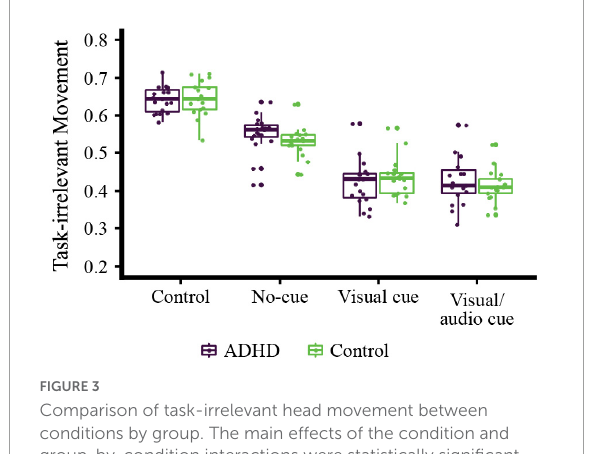
FIGURE3 Comparison of task-irrelevant head movement between conditions by group. The main effects of the condition and group-by-condition interactions were statistically significant, while the main effects of group were not. According to the post-hoc analyses performed with FDR correction, the healthy control (HC) group showed statistically significant differences between all conditions; however, the ADHD group did not show a significant difference of task-irrelevant head movement between the visual and visual/audio cue conditions.